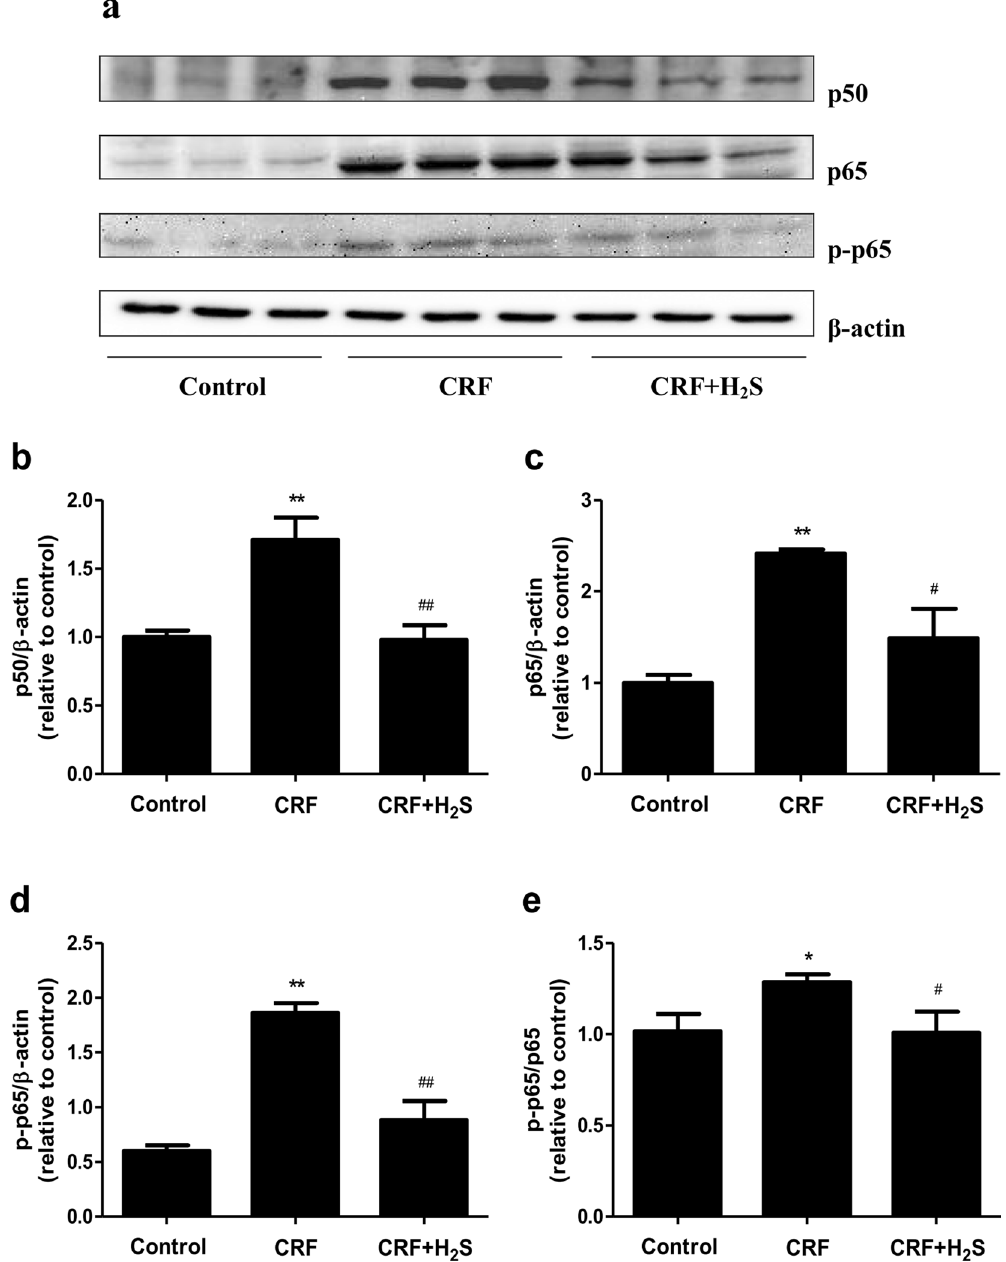
Figure 10. Effects of H 2 S on the NF- κ B pathway in the kidney of CRF rats. ( a ) The expression levels of p50, p65, and p-p65 were detected by Western blot. β -actin was used as an internal control. Bar graphs showed the quantification of p50 ( b ), p65 ( c ), p-p65 ( d ), and p-p65/p65 ( e ). Values were presented as mean ± SEM (n = 3); * P < 0.05, ** P < 0.01 compared with the control group; # P < 0.05, ## P < 0.01 compared with the CRF